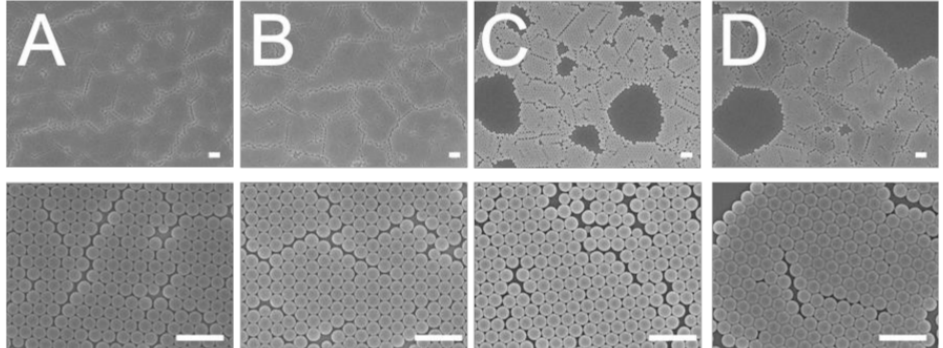
Figure 3. Influence of dispersant percentage on the assembly of 300 nm nanosphere arrays, ( A ) 7%, ( B ) 10%, ( C ) 30%, ( D ) 40%. (Spin speed was mainted 3000 rpm and spin time was 30 s. Scale bar: 1 µ m; Magnification: top—6000 × , bottom—25,000 × ).